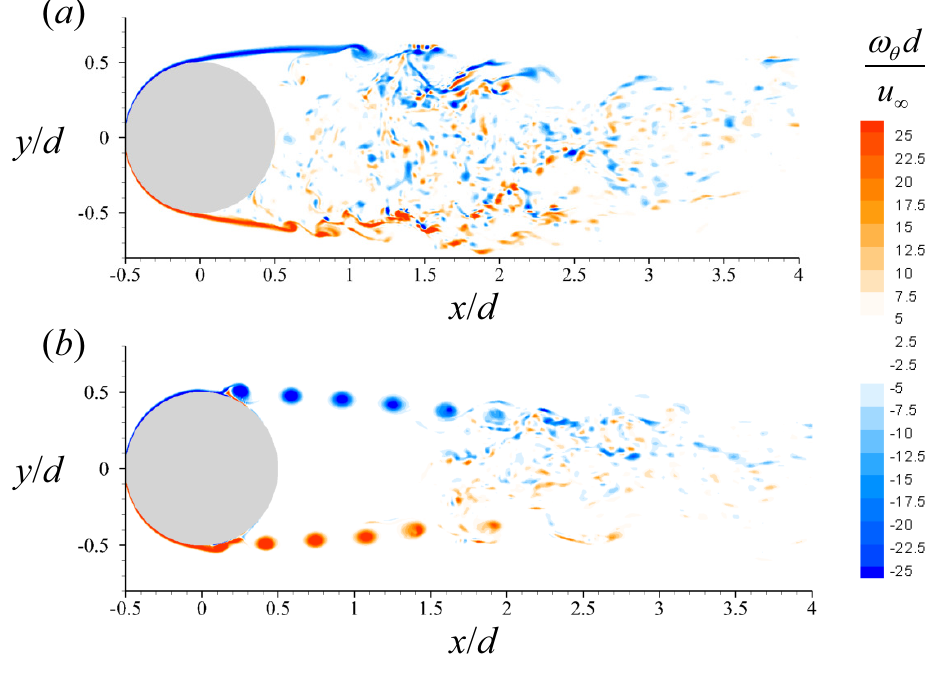
Figure 9. Contours of instantaneous azimuthal vorticity ( ω θ ) on a x – y plane: ( a ) uncontrolled flow; ( b ) controlled flow with f ∗ = 1.5 and V 0 / u ∞ =